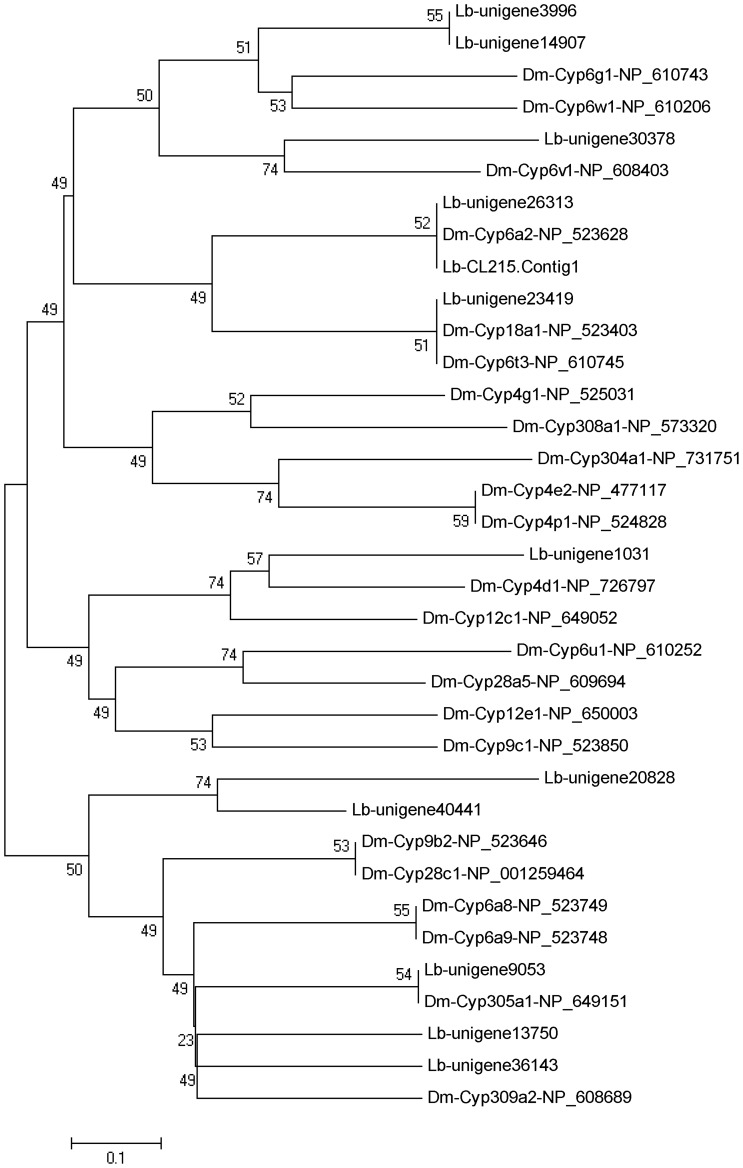
Phylogenetic tree of cytochrome P450s from Liposcelis bostrychophila (Lb) and Drosophila melanogaster (Dm).The tree was constructed from the multiple alignments using MEGA 5.0 software and generated with 1,000 bootstrap trials using the neighbor-joining method. The numbers indicate the bootstrap confidence values obtained for each node after 1,000 repetitions.